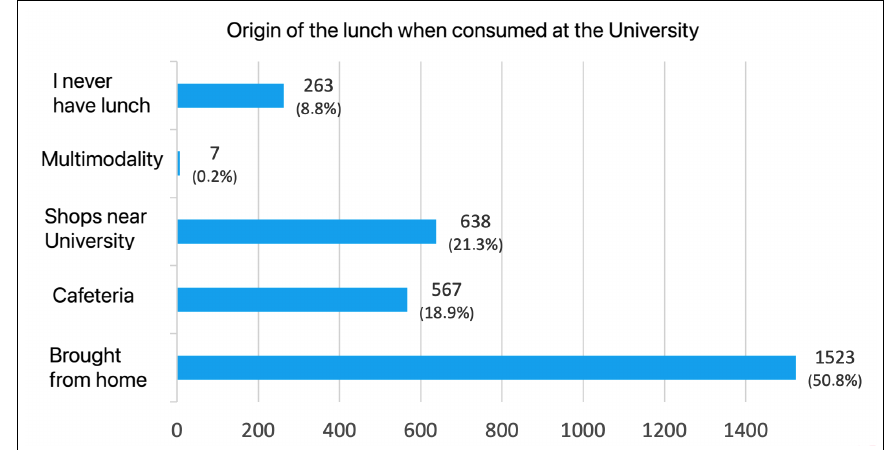
Figure 25. Origin of the lunch when consumed at the